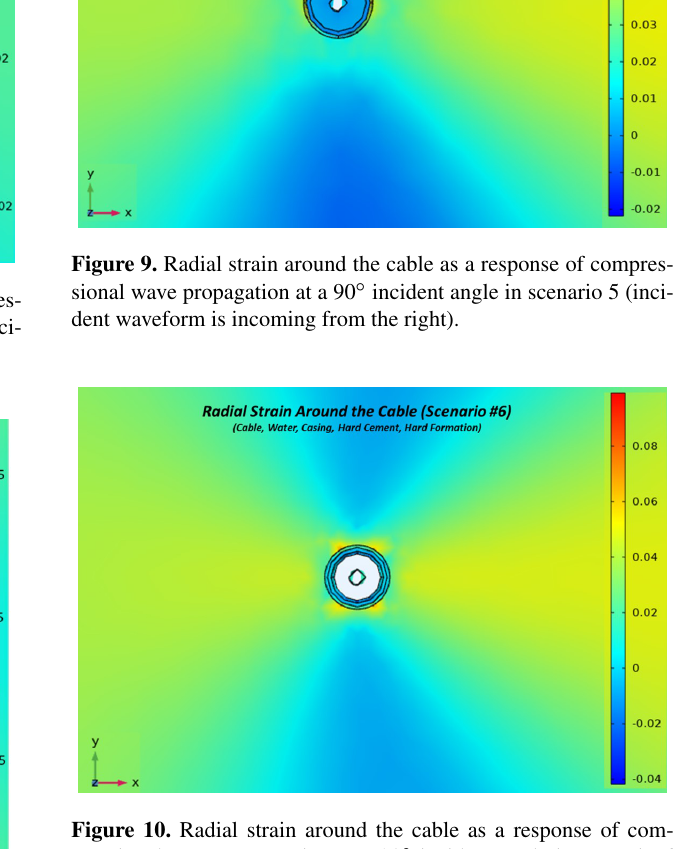
Figure 10. Radial strain around the cable as a response of com- pressional wave propagation at a 90 ◦ incident angle in scenario 6 (incident waveform is incoming from the